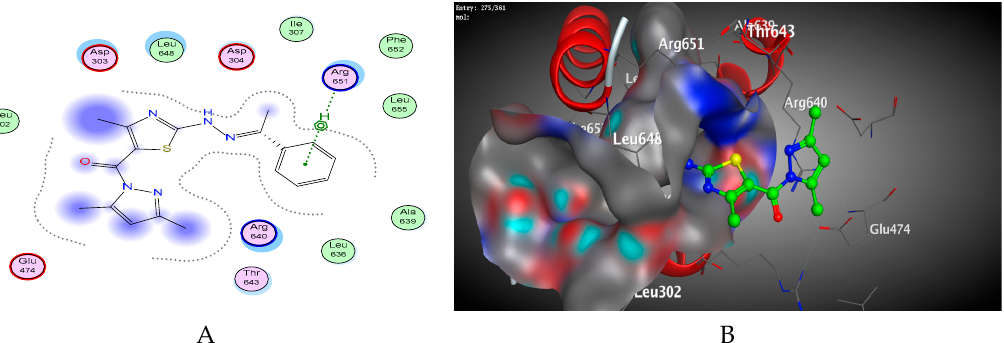
A B Figure 4. ( A ) 2D pose and ( B ) surface map of the interaction of 6 into the active sites of SARS-CoV-2 RdRp (PDB: 7bv2).